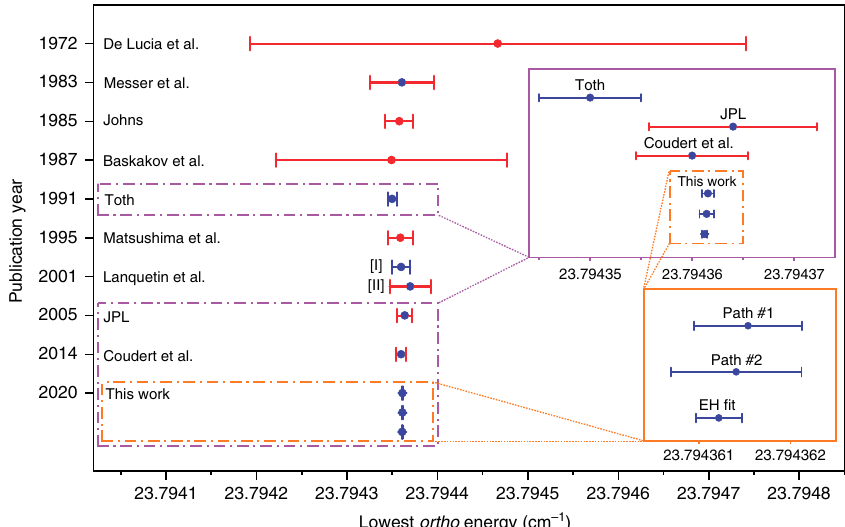
Fig. 7 Overview of selected determinations of the lowest ortho energy of H 2 16 O. On the vertical axis, the publication year is provided for the present and the literature 49,58 – 62,54,55,56 determinations. In ref. 54 , two different estimates ([I] and [II] in this fi gure) are reported. Data from Toth 62 , JPL 55 , and Coudert et al. 56 , as well as from this work are displayed in the purple inset. Our predictions [paths #1 and #2: paths of Fig. 6; EH fi t: ground vibrational- state effective Hamiltonian fi t (see the main text and Supplementary Note 2)] are repeated in the orange inset for improved transparency. Blue dots are published lowest ortho energy values, while the red ones have been calculated during the present study from the effective Hamiltonian parameters of the original publications. Similarly, blue error bars illustrate originally reported uncertainties, while the red ones are our estimates de fi ned in Supplementary Eq. 12 and analyzed in Supplementary Note 5. Source data are provided as a Source Data fi le.